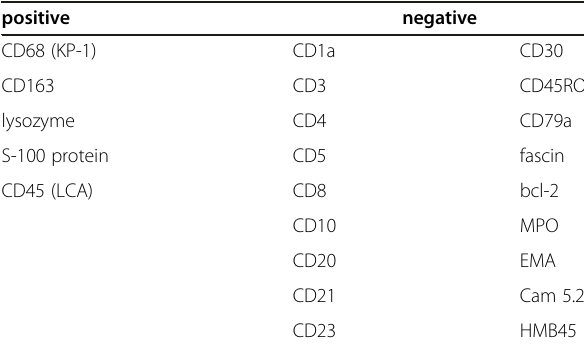
Table 2 Immunohistochemical profile of the tumor cells in our splenic HS case